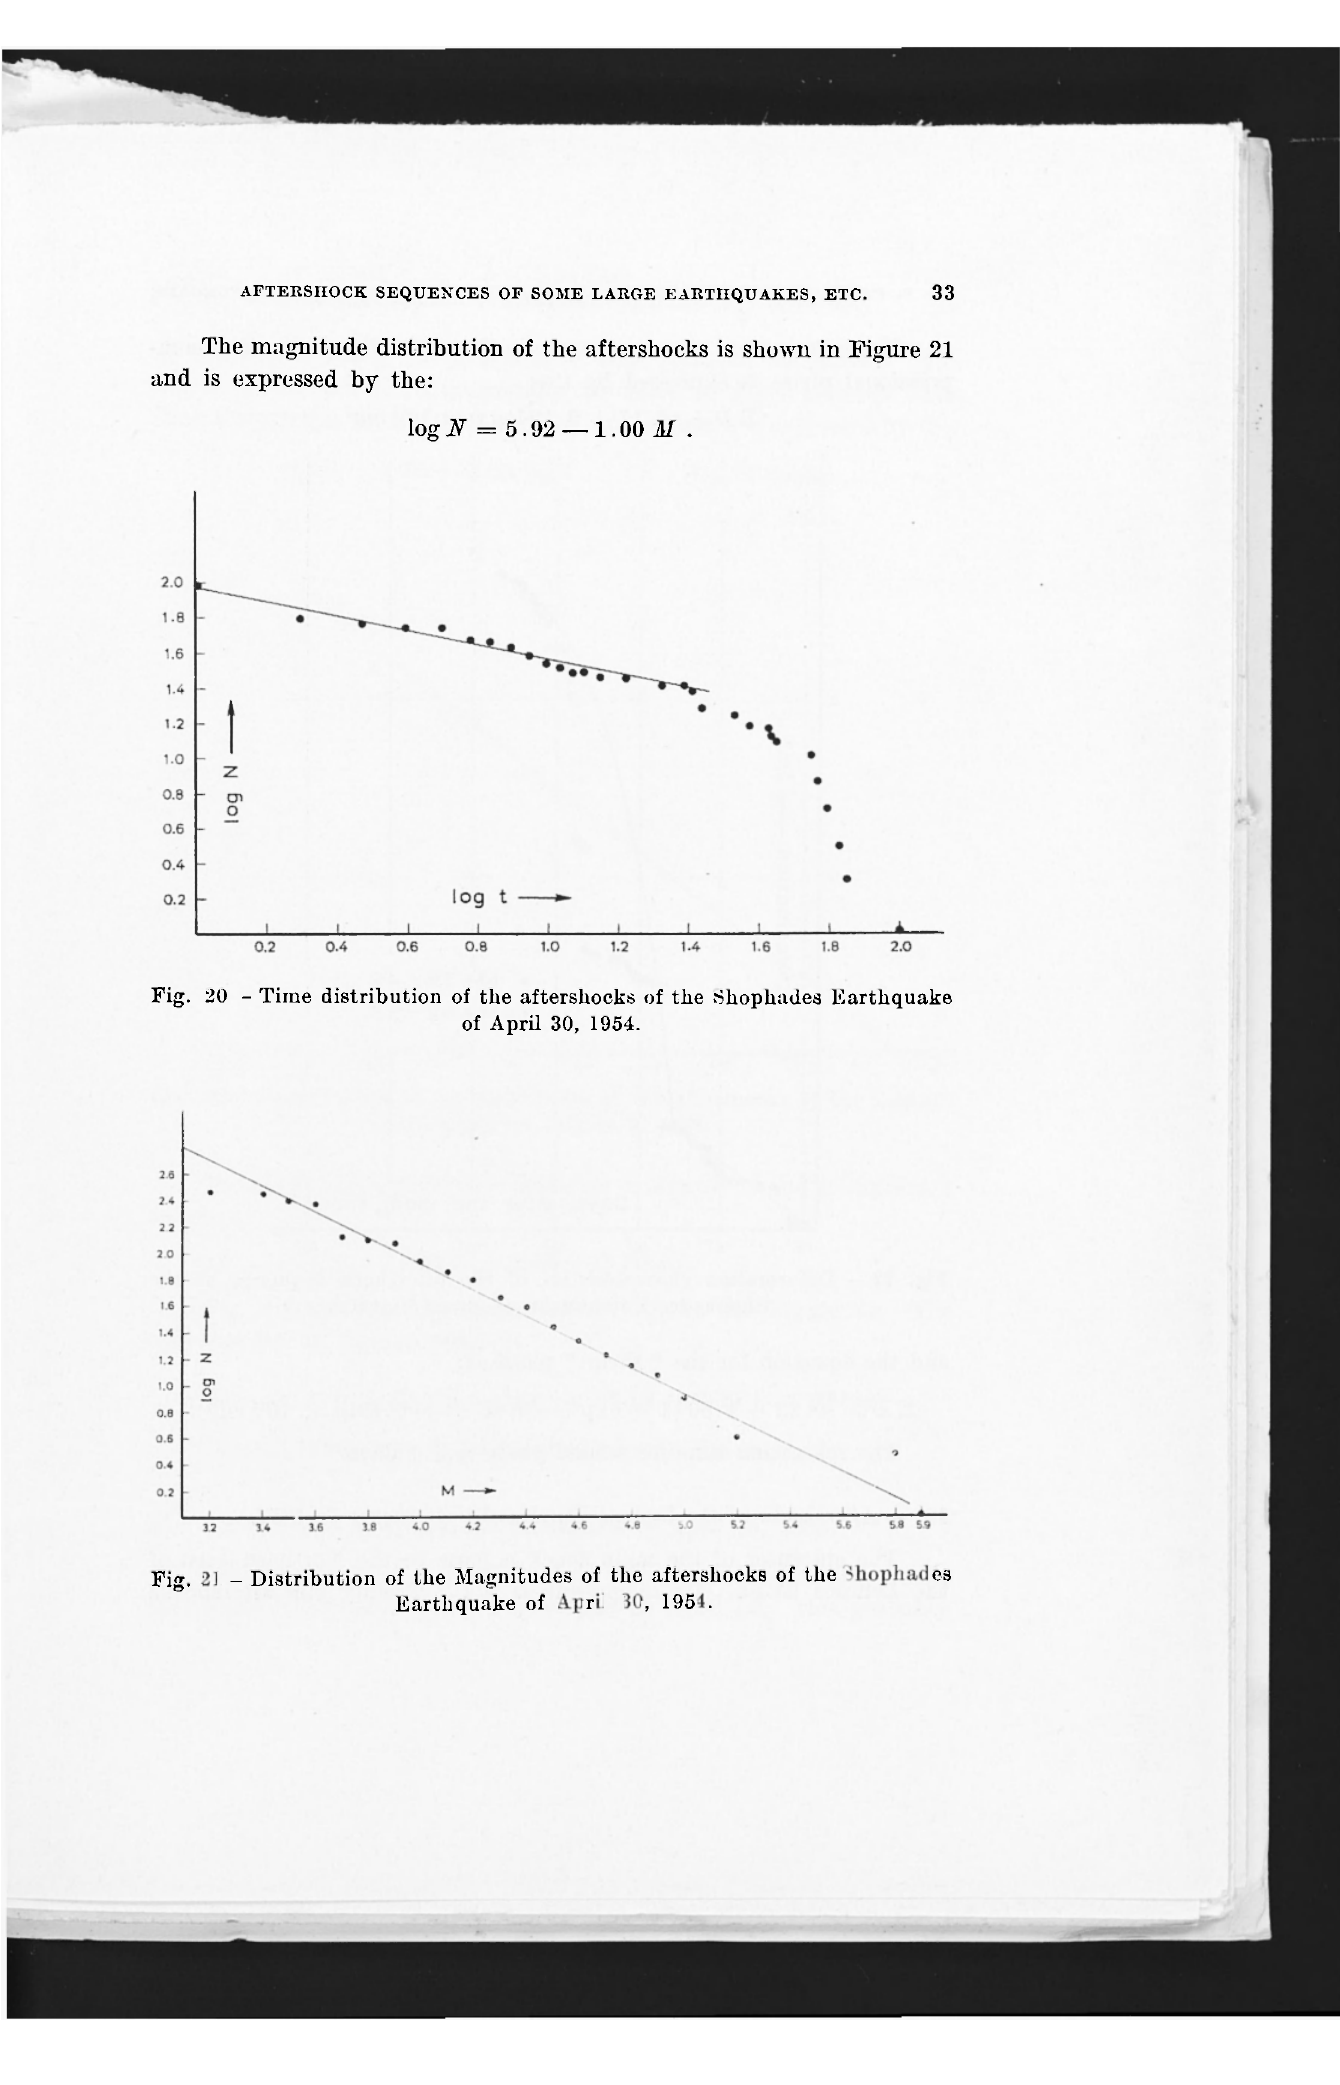
Fig. 35 - Distribution of the Magnitudes of the aftershocks of the Messinia Earthquake of February 19,